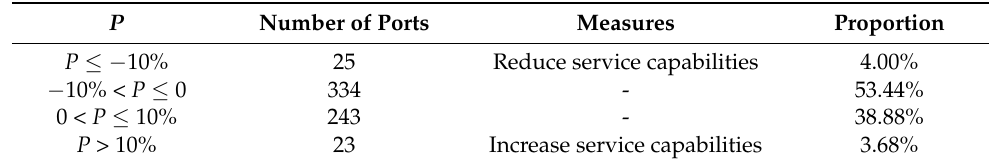
Table 6. Proportion of global container transport network reconfiguration (625